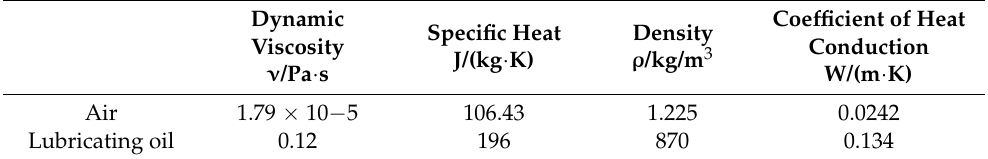
Table 2. The basic parameters of the air and lubricating